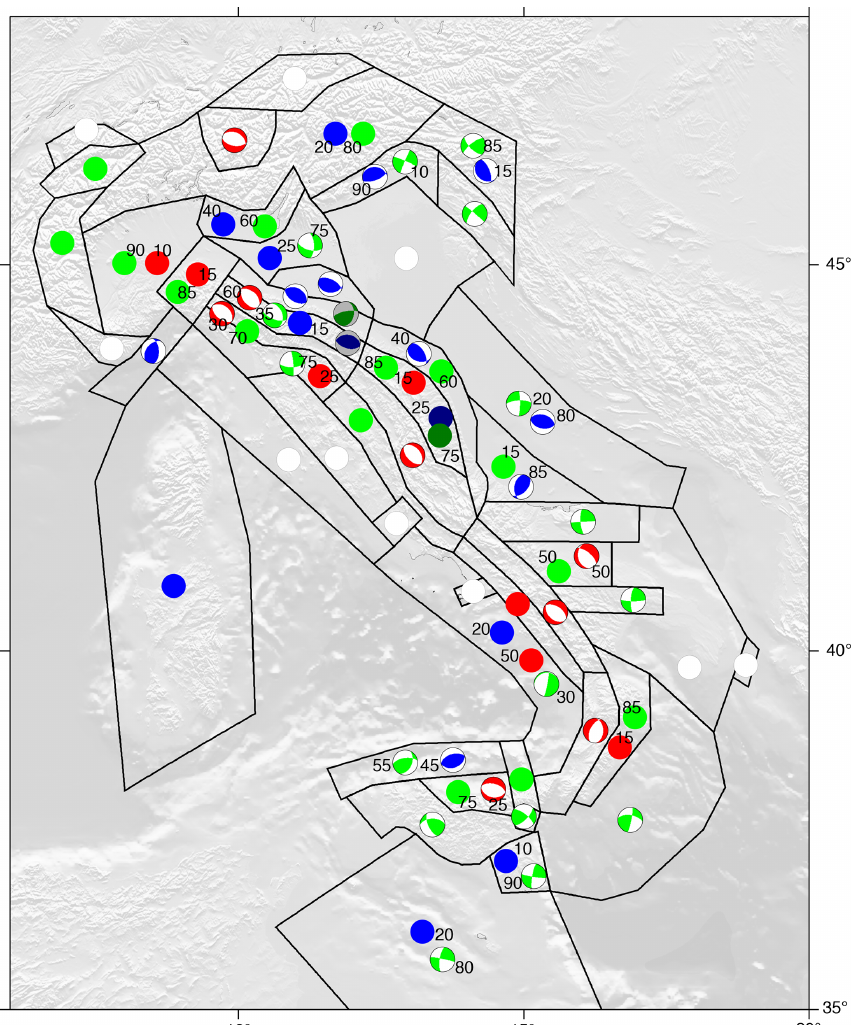
Figure 6. Map of the expected style of faulting obtained for each seismic zone. Full circles represent random seismic sources: white circles are 100% random; blue, red, and green circles are reverse, normal, and strike-slip random sources, respectively. The same colors also refer to cumulative focal mechanisms. Focal mechanisms with a grey background or circles with darker colors represent the sources for deeper layers. Numbers in black are the percentages of contribution to the final source when it is composed of different